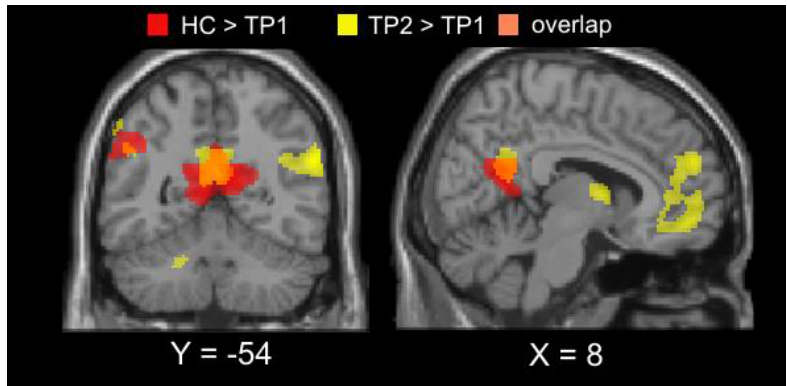
Figure 4. Qualitative comparison between (1) longitudinal changes in default mode network (DMN) deactivation associated with executive decision-making during delay discounting (regressor 1), following partial weight restoration (yellow regions) and (2) cross-sectional group di ff erences between acAN-TP1 and HC (red regions) to illustrate their overlap (orange regions). The respective t-maps were thresholded at p < 0.005 (uncorrected) for illustrative purposes. Note that while the cross-sectional group di ff erences depicted in the figure were based on data limited to the acAN-TP1 participants in the current longitudinal study, they largely mirrored the results of the King et al. [40] in a larger sample. acAN-TP1 = acutely underweight anorexia nervosa-time point 1; HC = healthy control.